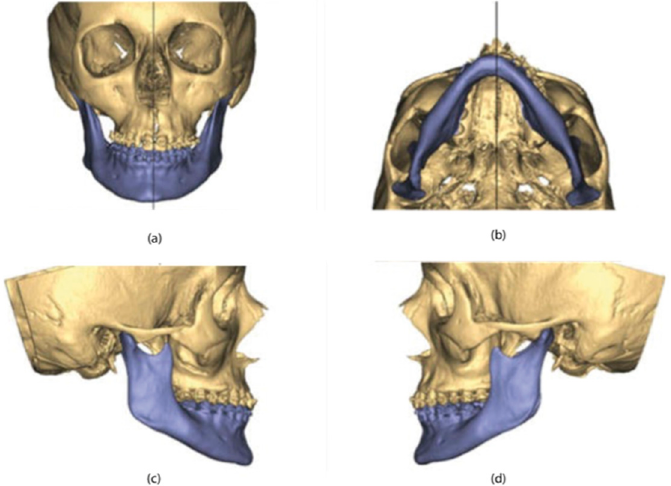
Figure 2. 3D maxillary and mandibular models: ( a ) front view; ( b ) bottom view; ( c ) right-side view; ( d ) left-side view.